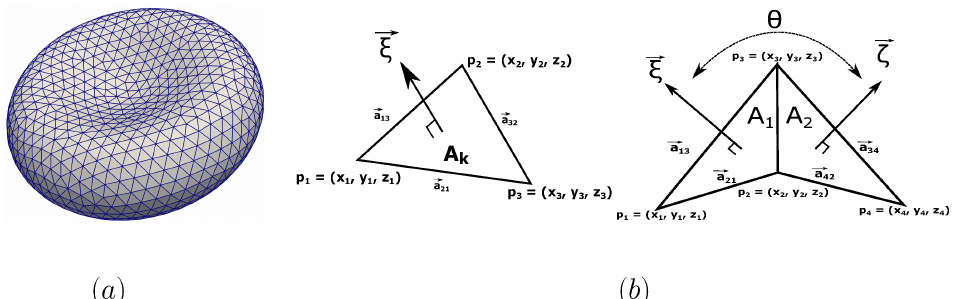
Figure 2. ( a ) Triangulated surface of the spectrin network attached to the lipid bilayer membrane. The numbers of vertices and triangles are denoted as N e and N v . The number of vertices varies from N v = 500 to N v = 27,344 points (nodes). ( b ) The definition of the normal surface vector ζ and the spontaneous angle θ between two adjacent elements. A element is defined by three vertices ( p 1 , p 2 , p 3 ) of the triangulated